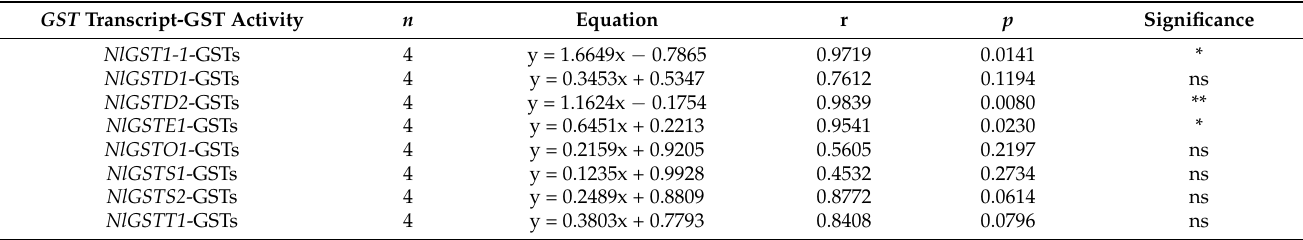
Table 2. Correlation of GST gene transcription level with GST activity in BPH.